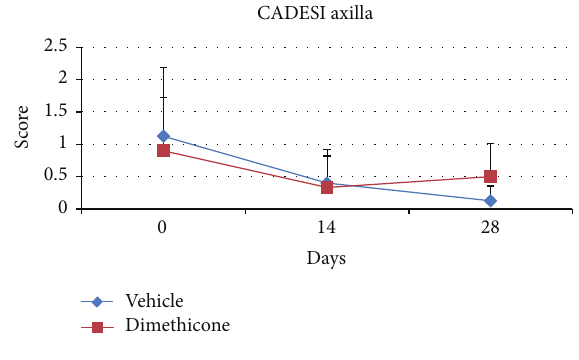
Figure 3: Mean regional Canine Atopic Dermatitis Extent and Severity Index (CADESI) of axilla. Error bars indicate ± standard deviation. ANOVA showed a significant effect of time, 𝑃 < 0.005 ; day 0 > day 28. The axilla CADESI score was decreased for both the vehicle group and the dimethicone group, over time.